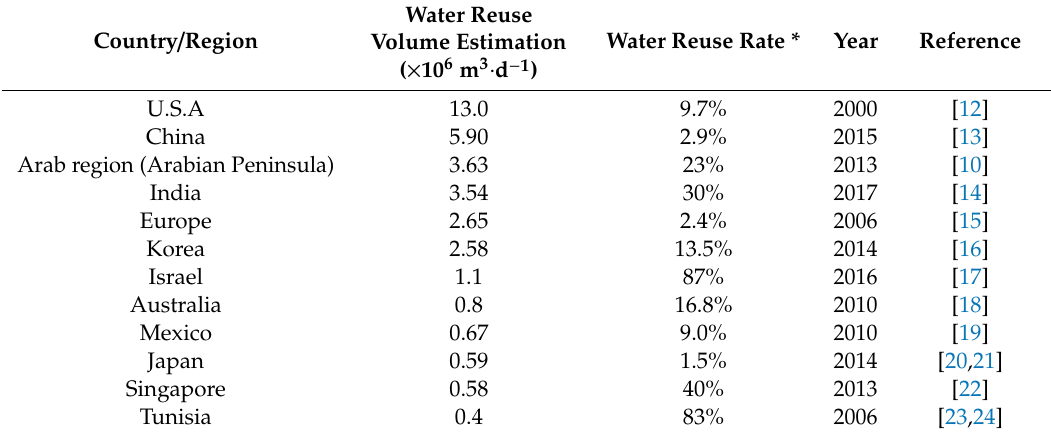
Table 2. lists the current status of water reuse rates in di ff erent countries. Table 2. Water reuse capacity in typical regions from 2006 to 2017